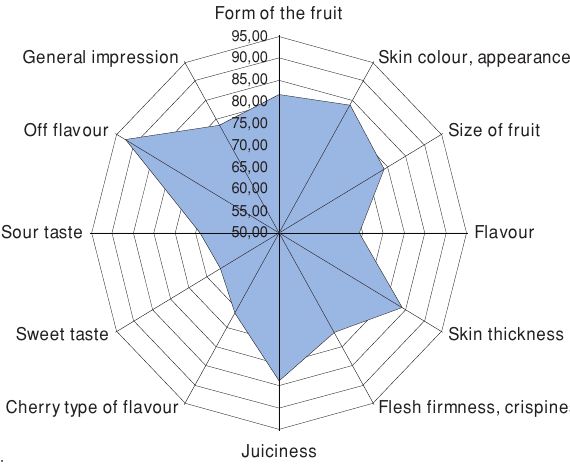
Figure 1. Evaluation of early ripening sweet cherry varieties according to the general impression